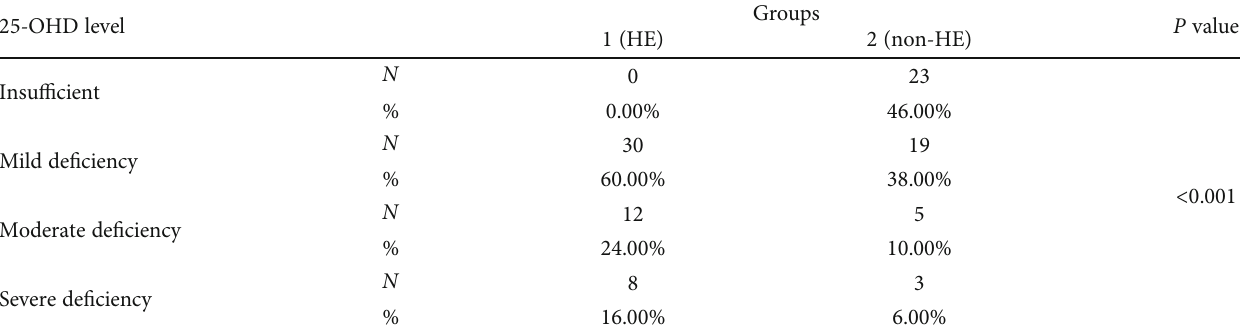
Table 3: Comparison of 25-OHD levels between the two